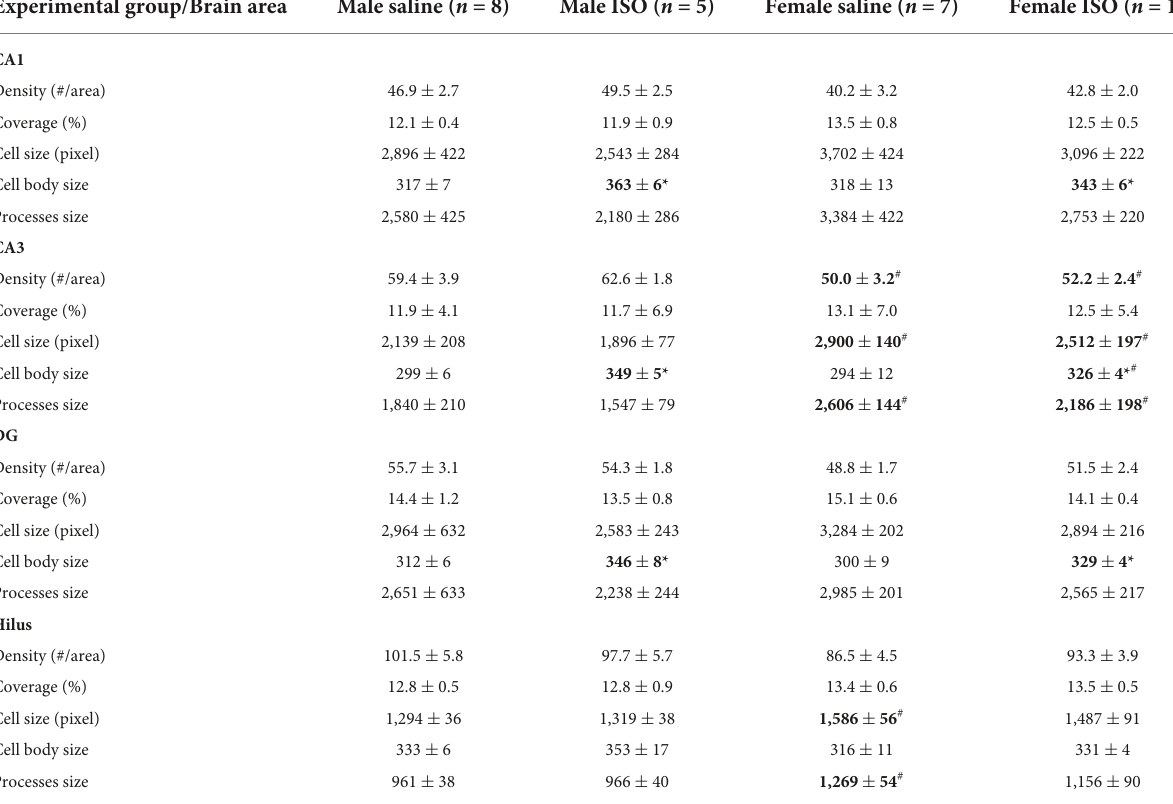
TABLE 2 Morphological parameters of microglia in the different hippocampal areas, CA1, CA3, dentate gyrus (DG) and Hilus, in the different experimental groups.